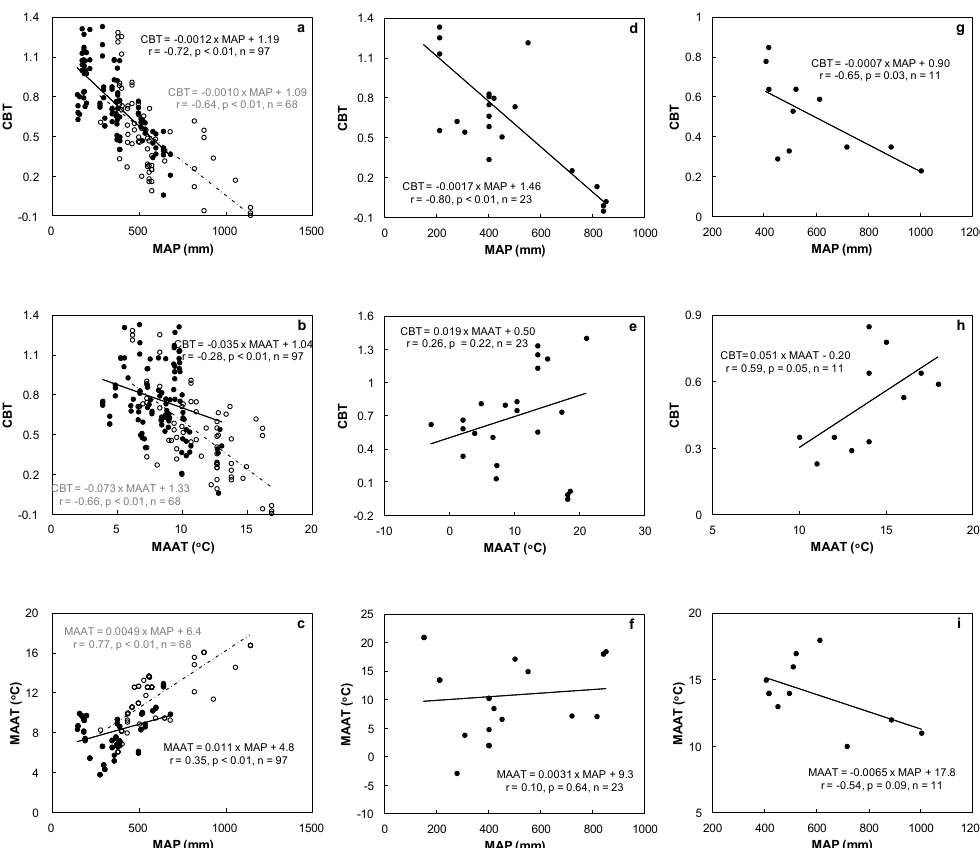
Figure 6. Plots showing the correlations of CBT with environmental variables and the relationships between MAP and MAAT for various alkaline soil data sets ( a–c : integrated Chinese alkaline soils; d–f : alkaline soils in the USA (De Jonge et al., 2014); g–i : alkaline soils in the Iberian Peninsula; Menges et al., 2014). Solid circles in (a–c) represent soils newly collected in this study, while circles are published data from Yang et al. (2012, 2014a) and Xie et al.